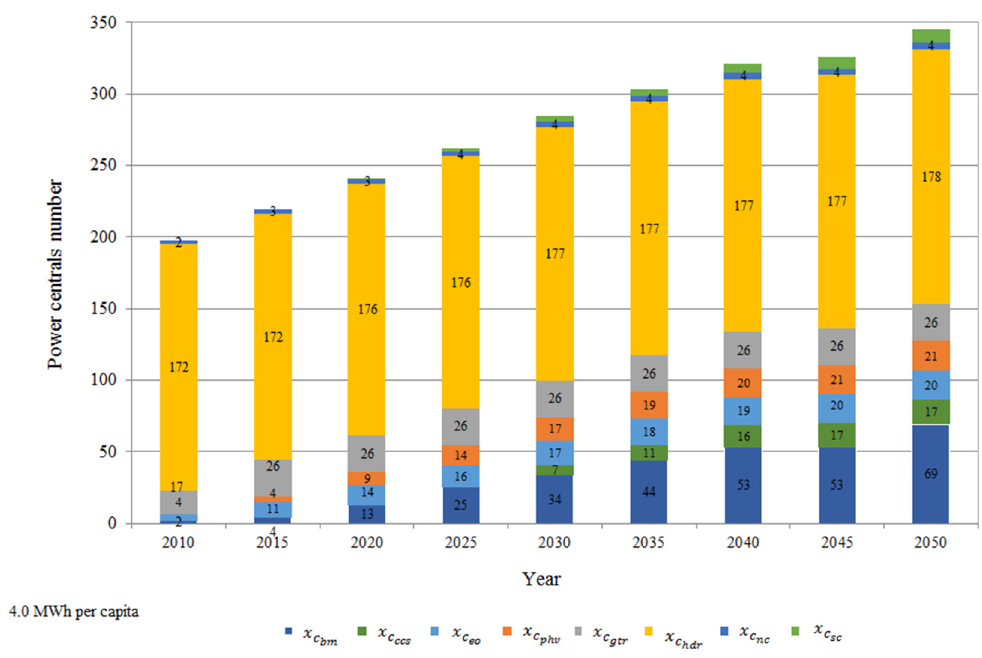
Figure 13. Optimized power plants number from clean energy resource for 4.0 MWh per capita demand with the LVF model.